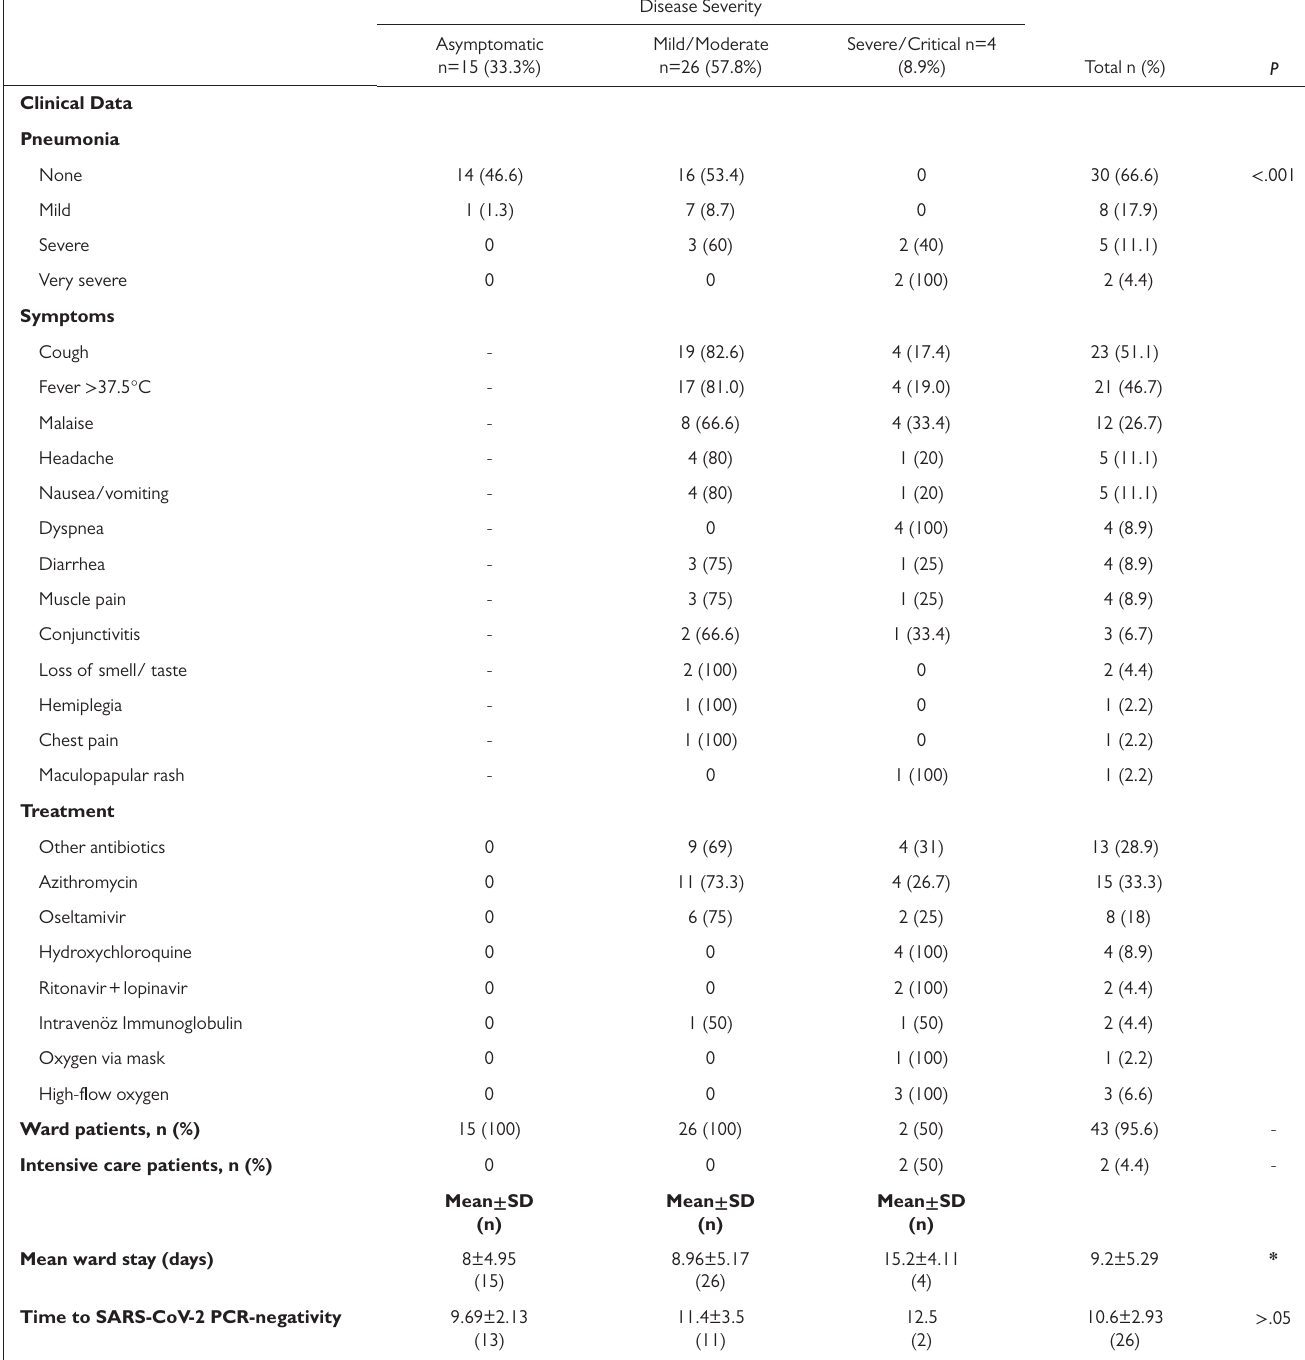
Table 2. Clinical Data of Patients According to Disease Severity